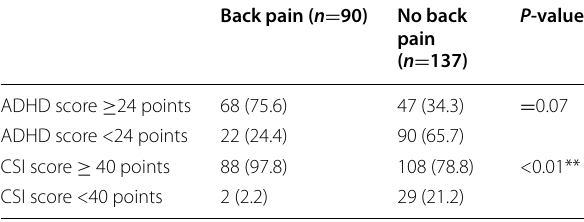
Table 5 Logistic regression model to test the effect of attention deficit hyperactivity disorder on back pain in the absence of central sensitization